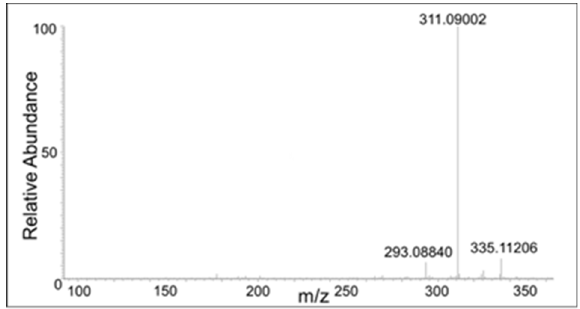
Figure 10. The CID mass spectrum of the m/z 353 mass unit ion eluting at 20 min.